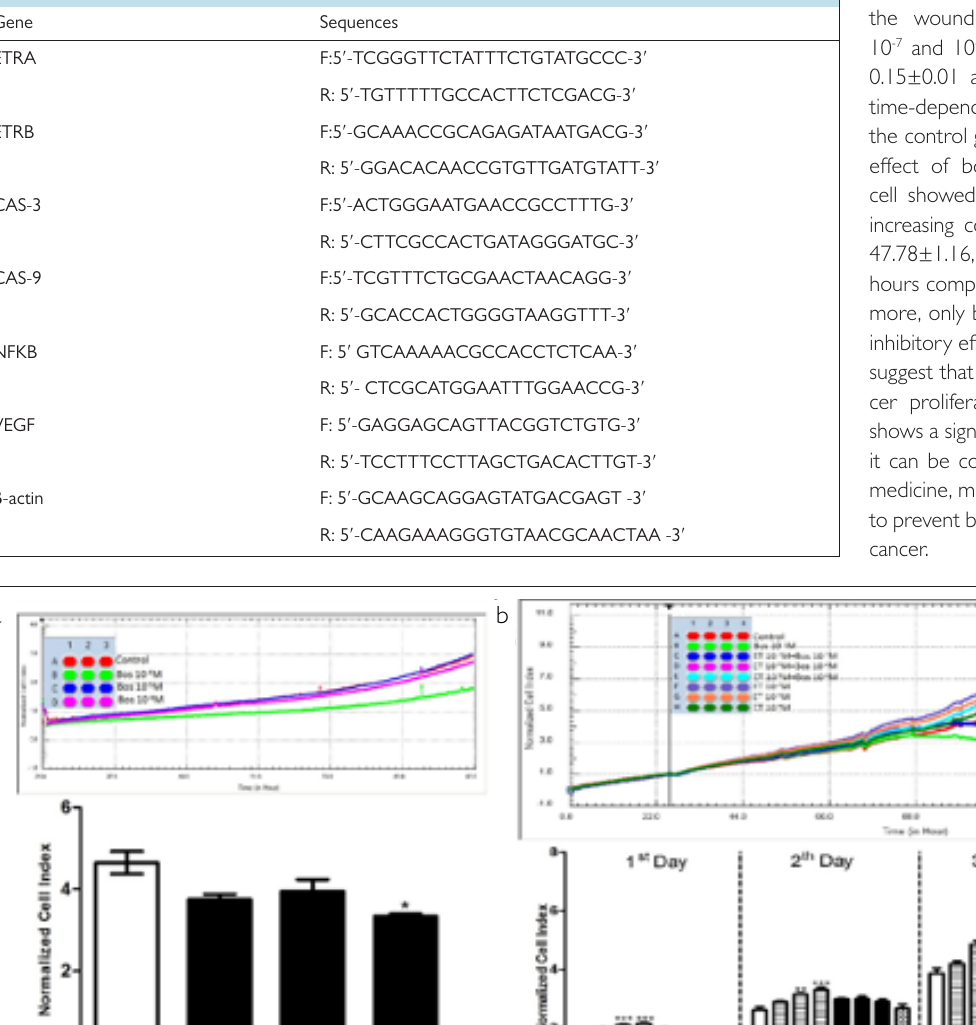
Table 1. RT-PCR primer probe gene sequences